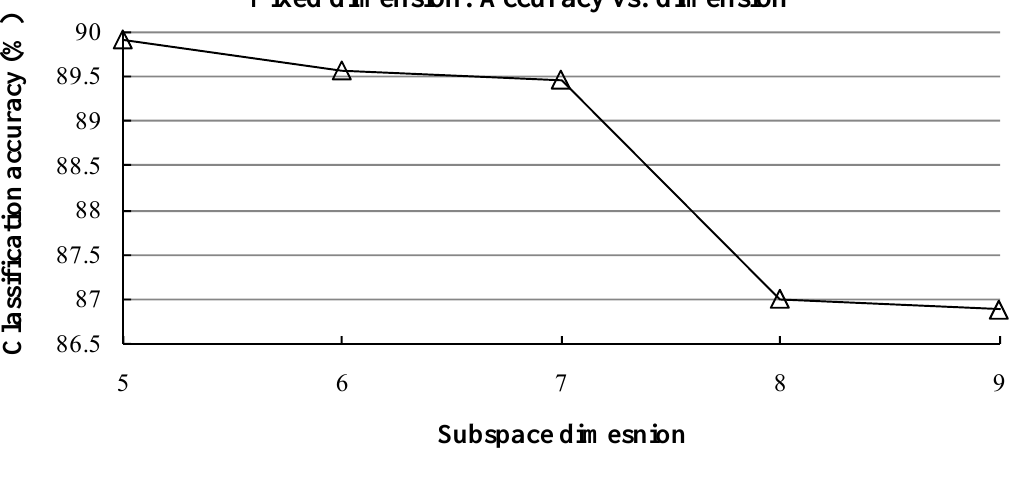
(c) Fixed dimension. Iterations vs. dimesnion Subspace dimension